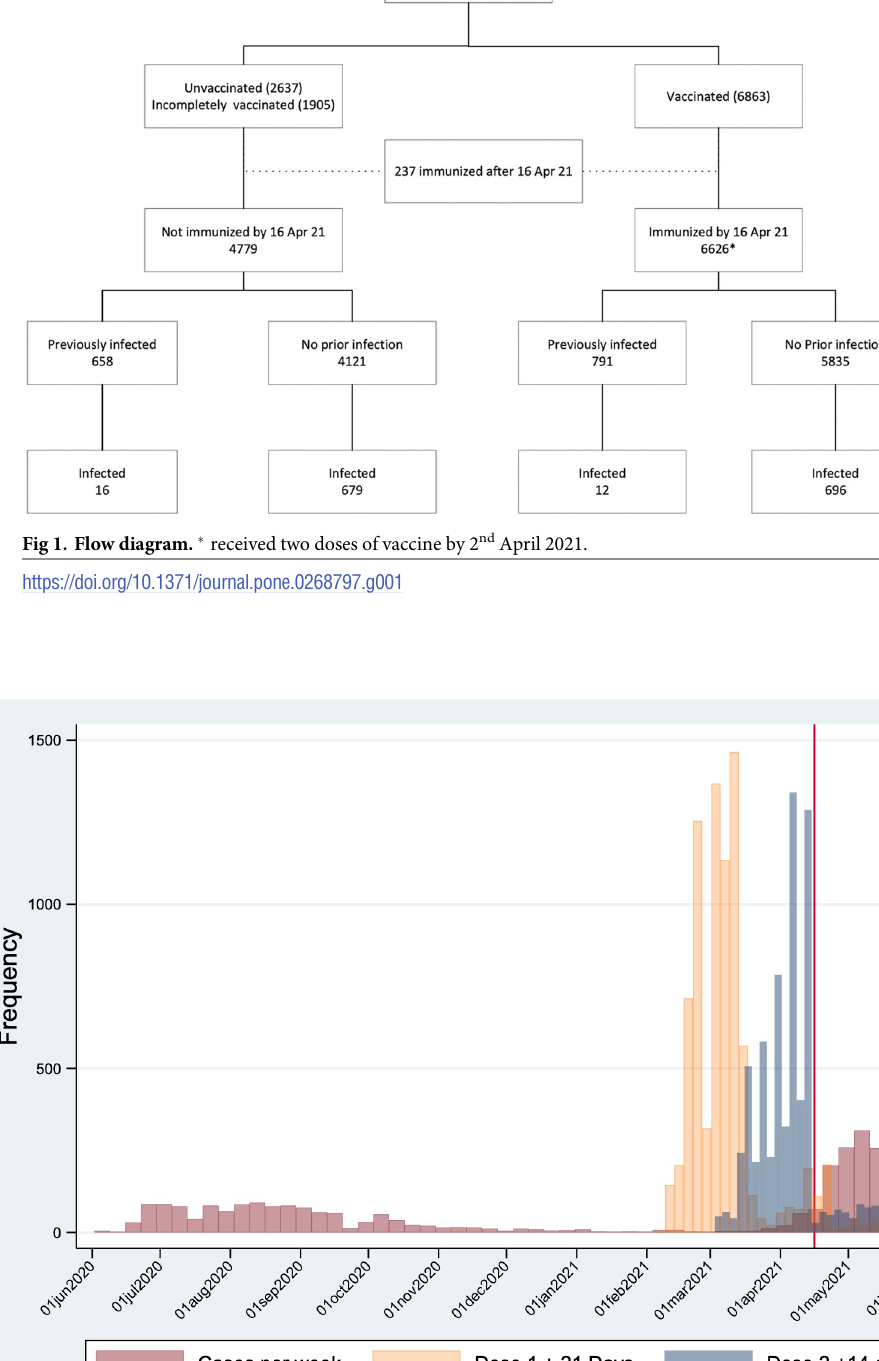
PLOS ONE | https://doi.org/10.1371/journal.pone.0268797 May 20,